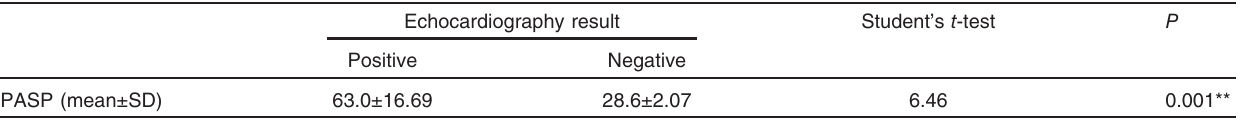
Echocardiography result